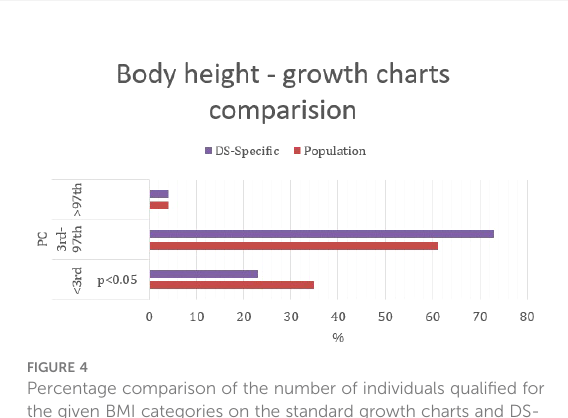
FIGURE 2 Percentage comparison of the number of individuals quali fi ed for the given body weight categories on the standard growth charts and DS-specialized growth